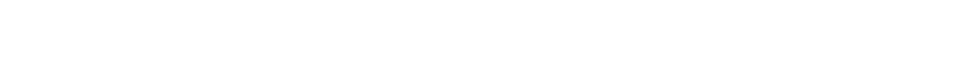
Table 9 Market formulation for grape seed